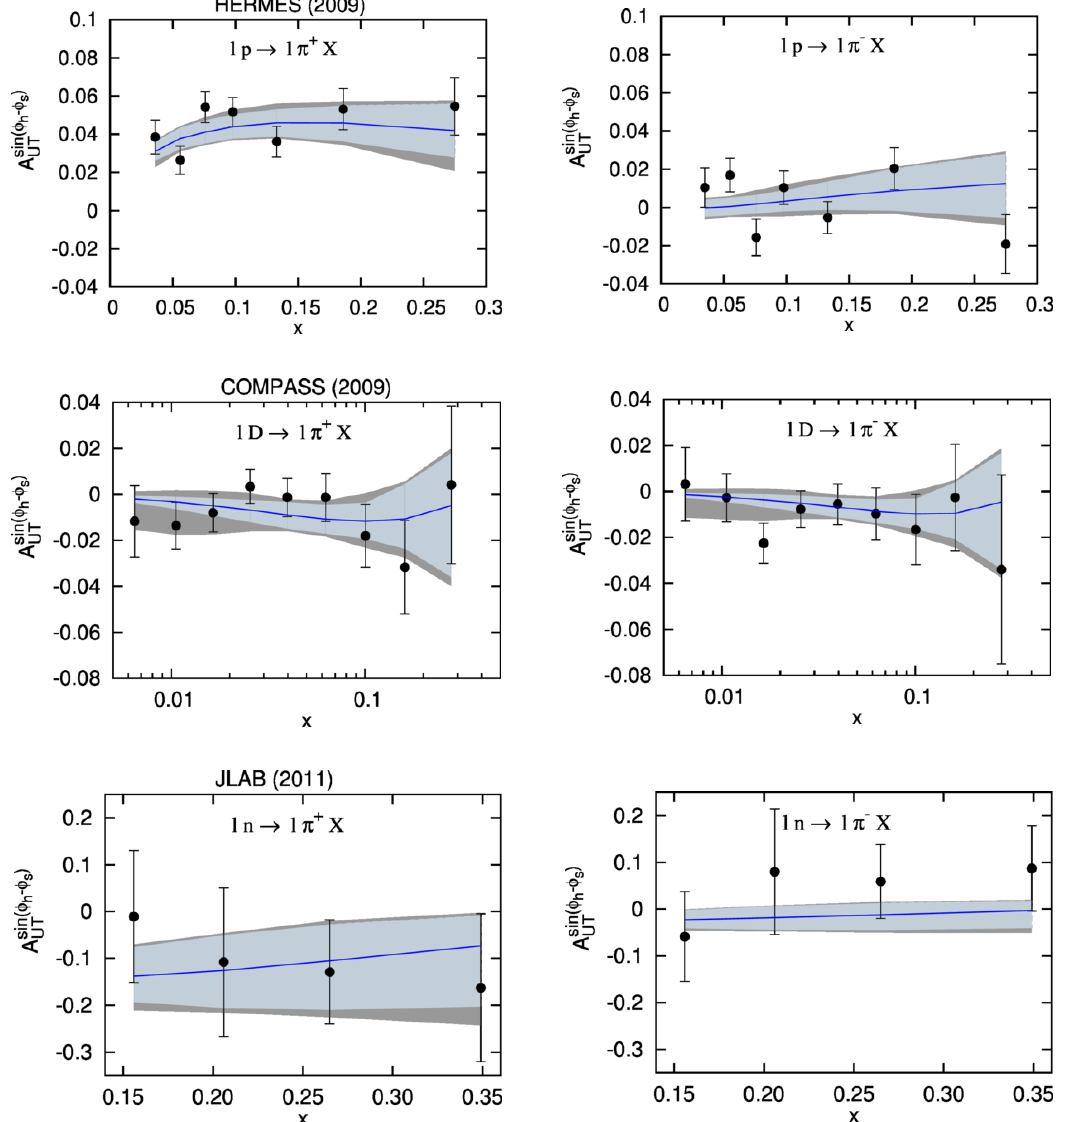
Figure 6 . The results obtained from the reference (cid:12)t and the (cid:11) -(cid:12)t are compared to the HERMES measurements of the SIDIS Sivers asymmetry for (cid:25) (cid:6) production o(cid:11) a proton target [28] (upper panels), to the COMPASS measurements of the SIDIS Sivers asymmetry on a LiD target [29] for (cid:25) (cid:6) production (middle panels), and to the JLab data for (cid:25) (cid:6) production on a 3 He target [30] (bottom panel). Here we show the x dependence only. The shaded region corresponds to our estimate of 2 (cid:27) C.L. error band. The light-blue bands correspond to the uncertainties of the reference (cid:12)t (only N and (cid:12) free parameters), while the (larger) gray bands correspond to the uncertainties of u ( d ) u ( d ) the (cid:11) -(cid:12)t, which includes also the (cid:11) parameters. u ( d )